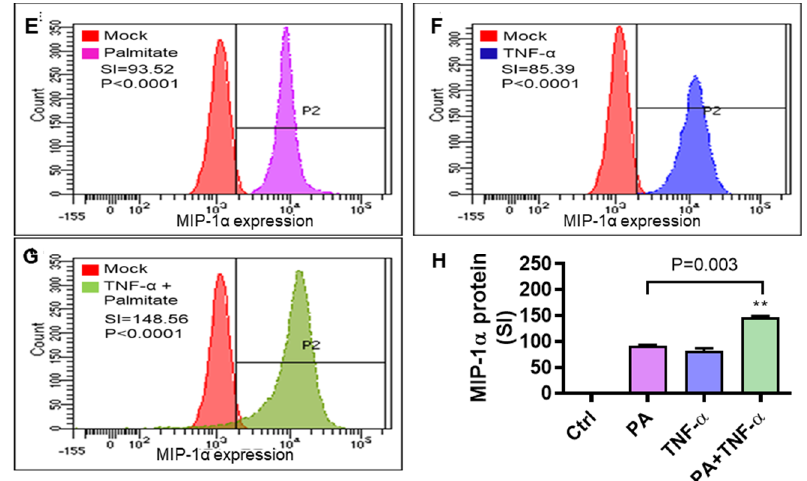
Figure 1. Enhanced expression of MIP-1α in THP-1 monocytic cells and primary human macrophages co-stimulated with palmitate and TNF-α. Human monocytic THP-1 cells and primary human macrophages were stimulated with palmitate (200 μM) and/or TNF-α (10 ng/mL), while control wells were treated with 1%BSA. Cells were incubated at 37 °C for 24 h and cells were collected for total RNA extraction for measuring MIP-1α gene expression and supernatants were collected for measuring MIP-1α secreted protein as described in the Materials and Methods section. The representative data (mean ± SEM) from 3 independent determinations with similar results show significantly increased expression of ( A ) MIP-1α mRNA ( P < 0.0001) and ( B ) MIP-1α secreted protein ( P < 0.0001) in THP-1 monocytic cells co-stimulated with palmitate and TNF-α compared to stimulation with either TNF-α or palmitate. Similarly, the representative data (mean ± SEM) from three independent determinations with similar results show significantly elevated expression of ( C ) MIP-1α transcripts ( P = 0.022) and ( D ) MIP-1α secreted protein ( P = 0.0001) in primary human macrophages co-stimulated with palmitate and TNF-α compared to stimulation with either TNF-α or palmitate. ( E – G ) The representative flow cytometry histograms from 3 independent experiments with similar results also show the upregulated intracellular protein expression of MIP-1α in THP-1 cells co-stimulated with palmitate and TNF-α (SI (staining index) = 148.56) compared to those stimulated with either palmitate (SI = 93.52) or TNF-α (SI = 85.39). ( H ) MIP-1α protein expression induced by co-stimulation with palmitate and TNF-α was significantly higher than that induced by palmitate or TNF-α alone ( P = 0.003). SI: Staining index; * P < 0.05, ** P < 0.01, *** P < 0.001 and **** P < 0.0001.